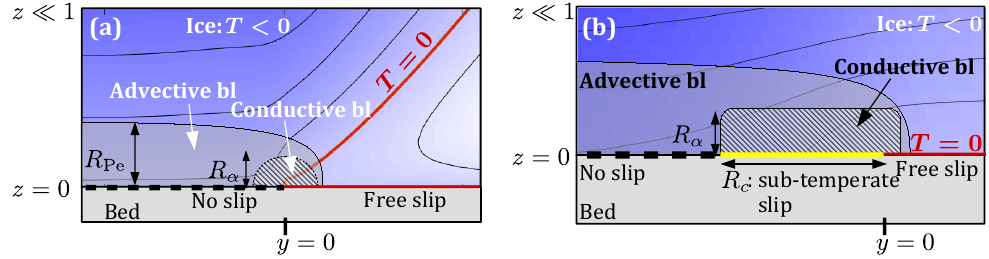
Figure 5. Boundary layer structure for asymptotic calculations with large α and Pe , without subtemperate slip (a) and with subtemperate slip (b) . The background temperature profiles are enlargements of typical profiles in this asymptotic limit, with same color scale as in Fig. 3. In the outer advective boundary layer the temperature field close to the bed is advected from the ice ridge towards the inner conductive boundary layer. In the case of a no-slip–free-slip transition at the bed the conductive boundary layer consists of a small region around the slip transition (a) . In the case of subtemperate slip, the conductive boundary layer is a region of small vertical extent which stretches along the length of the subtemperate slip region (b) . Within the conductive boundary layer, heat dissipation is balanced by diffusion.